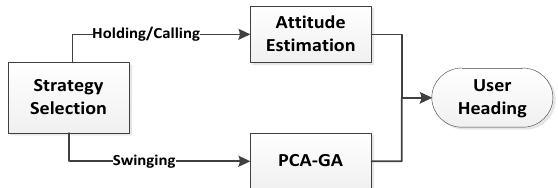
Figure 7. Flow chart of the user heading estimation